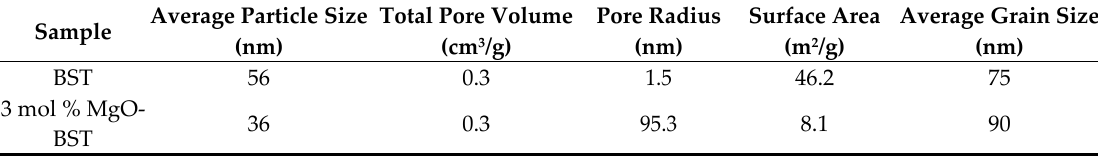
Table 1. Detailed properties of the nanocomposites in this research before and after